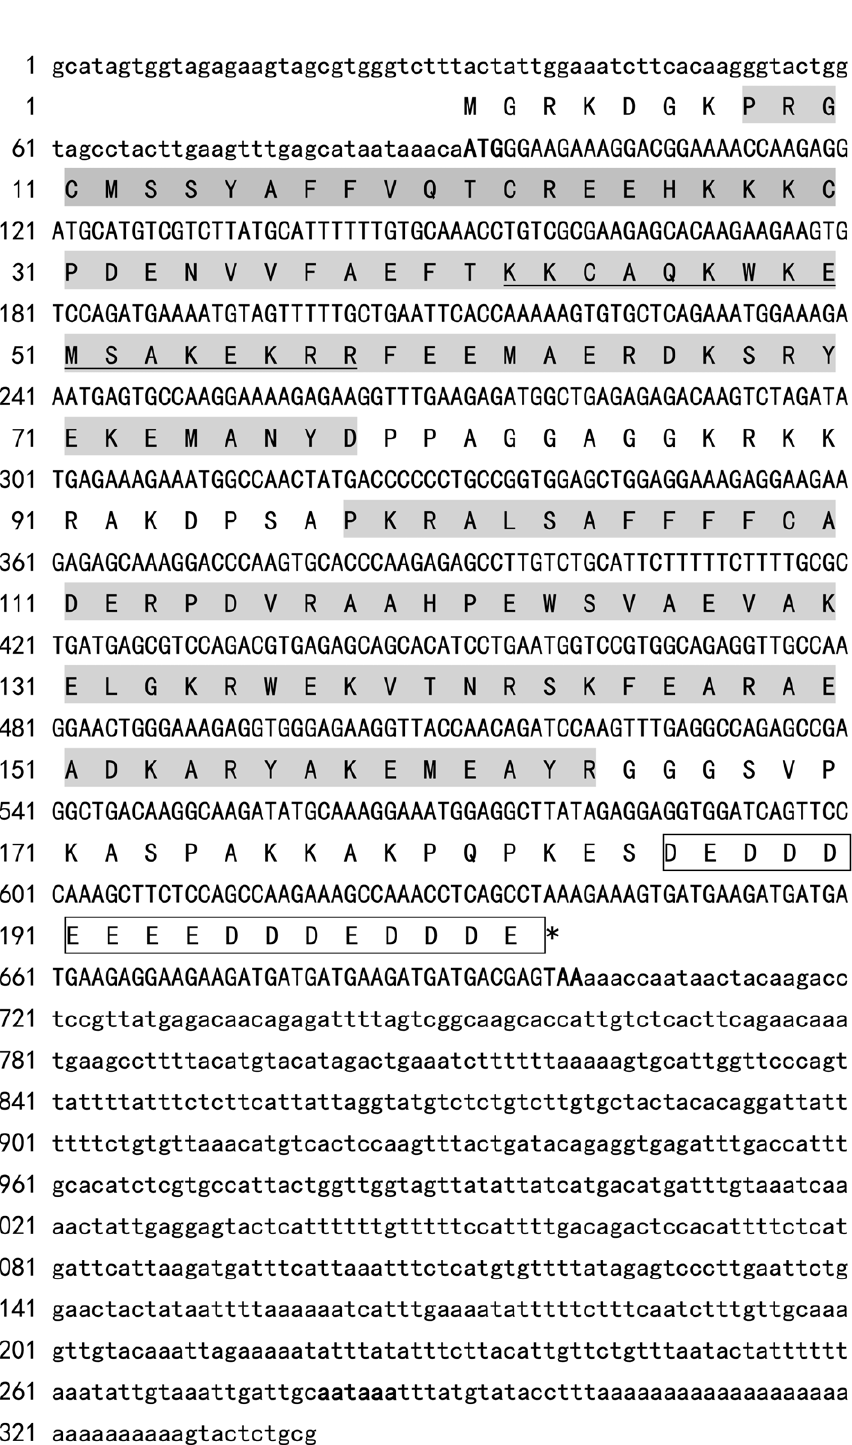
Figure 1. Nucleotide and deduced amino acid sequences of Ca-HMGB from oyster, Crasstoreaariakensis Gould. The ORFs of the nucleotide sequences and deduced amino acid are shown in upper-case letters, the 5 9 and 3 9 -UTRs are shown in lower-case letters. Nucleotides and amino acids are numbered on the left of the sequences. The initiation codons, stop codons and the poly (A) signals (aataaa) are in bold. The HMG box A and B motifs are shaded (former one is box A and the later one is box B), the acidic C-tails are boxed and NLS is underlined.